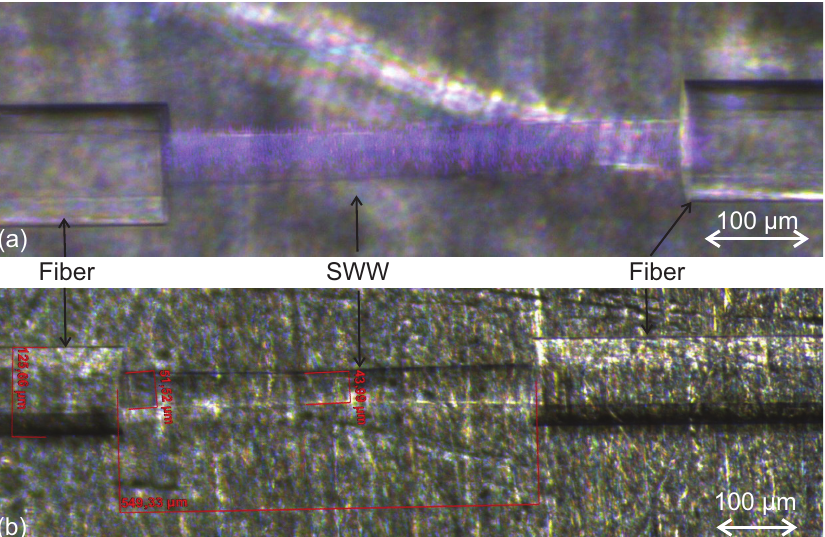
Figure 2. Image ( a ) is illustrating the creation of a SWW by a self-trapped laser beam with a wavelength of λ = 405 nm between two OM2-fibers with a core size of 50µm and a cladding diameter of 125µm, respectively. The red bars in the lower image ( b ) represents the measuring point for determining the thickness and length of the SWW. The fact that the width of the SWW decreases in the middle between the fibers is studied systematically as a function of the relevant process parameters in the next steps.